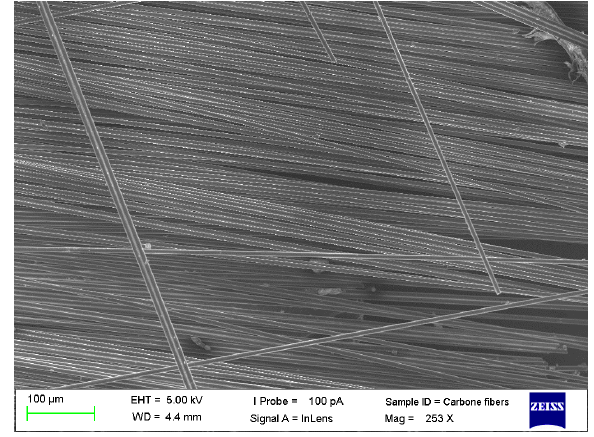
Figure 2. Carbon fiber fabric magnified 250 × .